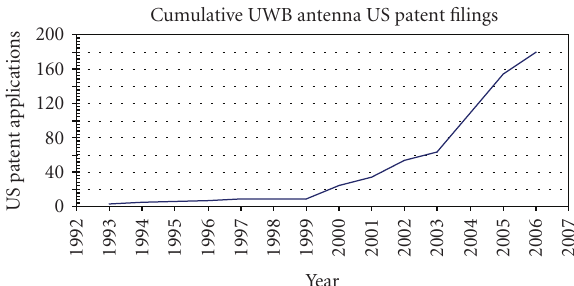
Figure 2: Cumulative UWB antenna US patent activity by year